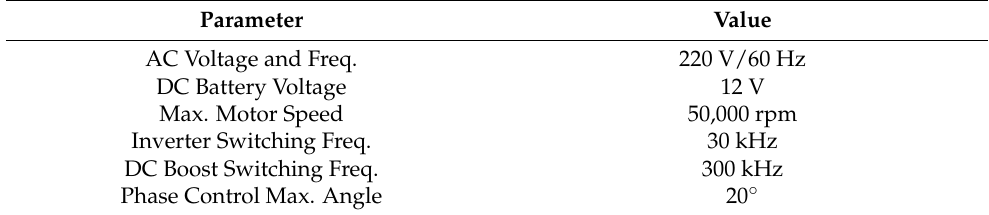
Figure 11. Configuration of the experiment setup. Table 4. Test condition parameters.